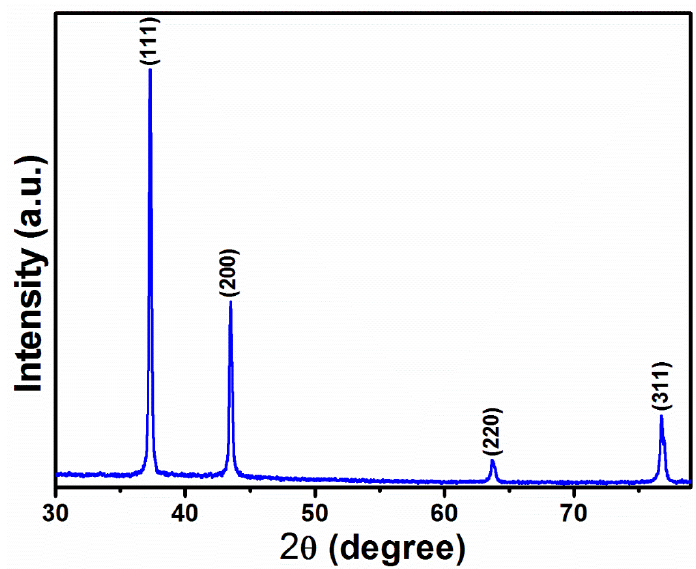
Figure 2. XRD pattern of silver nanoparticles.